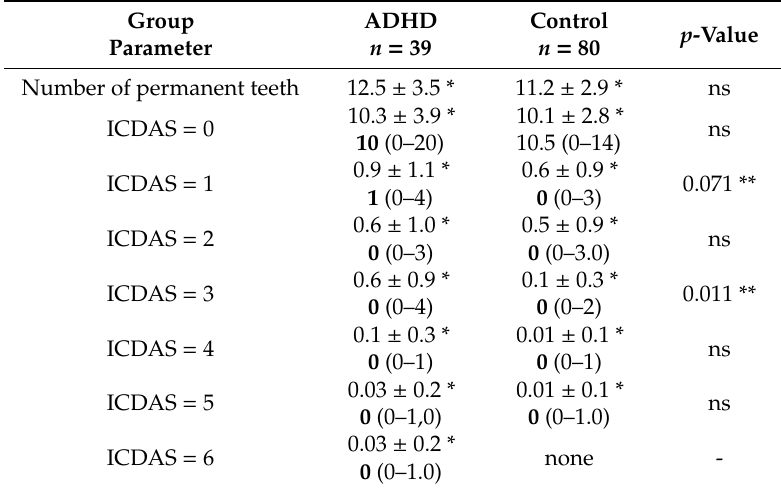
Table 4. Statistical analysis for permanent dentition according to ICDAS score in ADHD and control